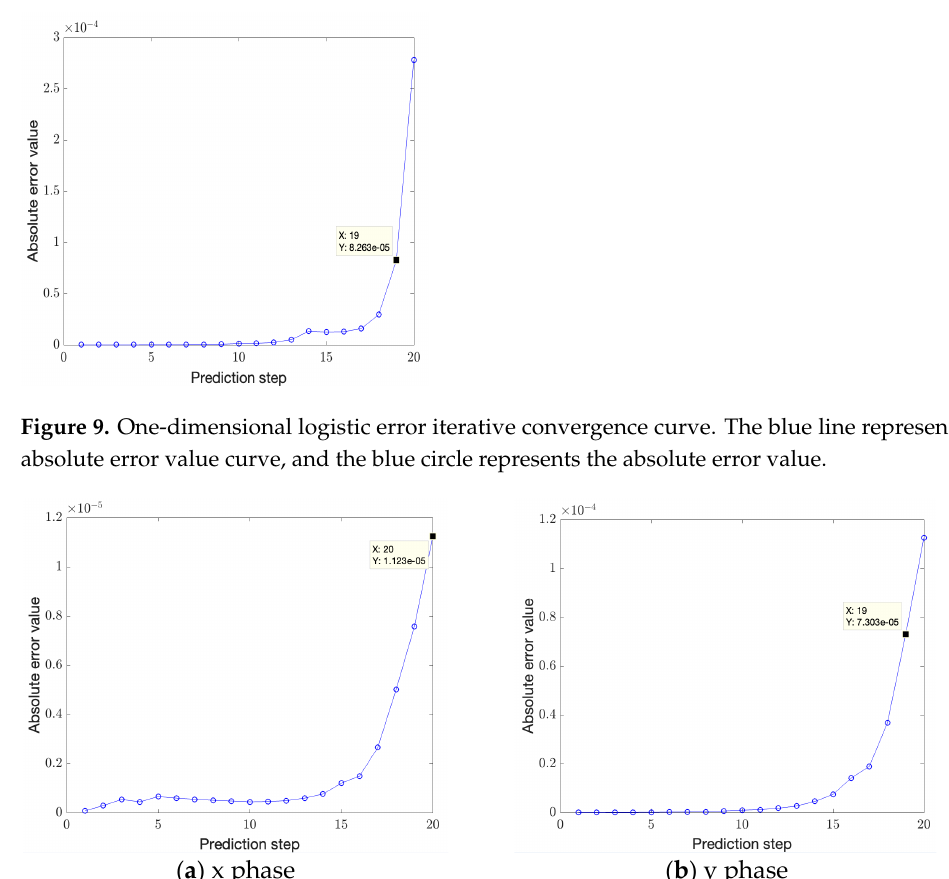
Figure 10. Two-dimensional Henon error iterative convergence curve. The blue line represents the absolute error value curve, and the blue circle represents the absolute error value.